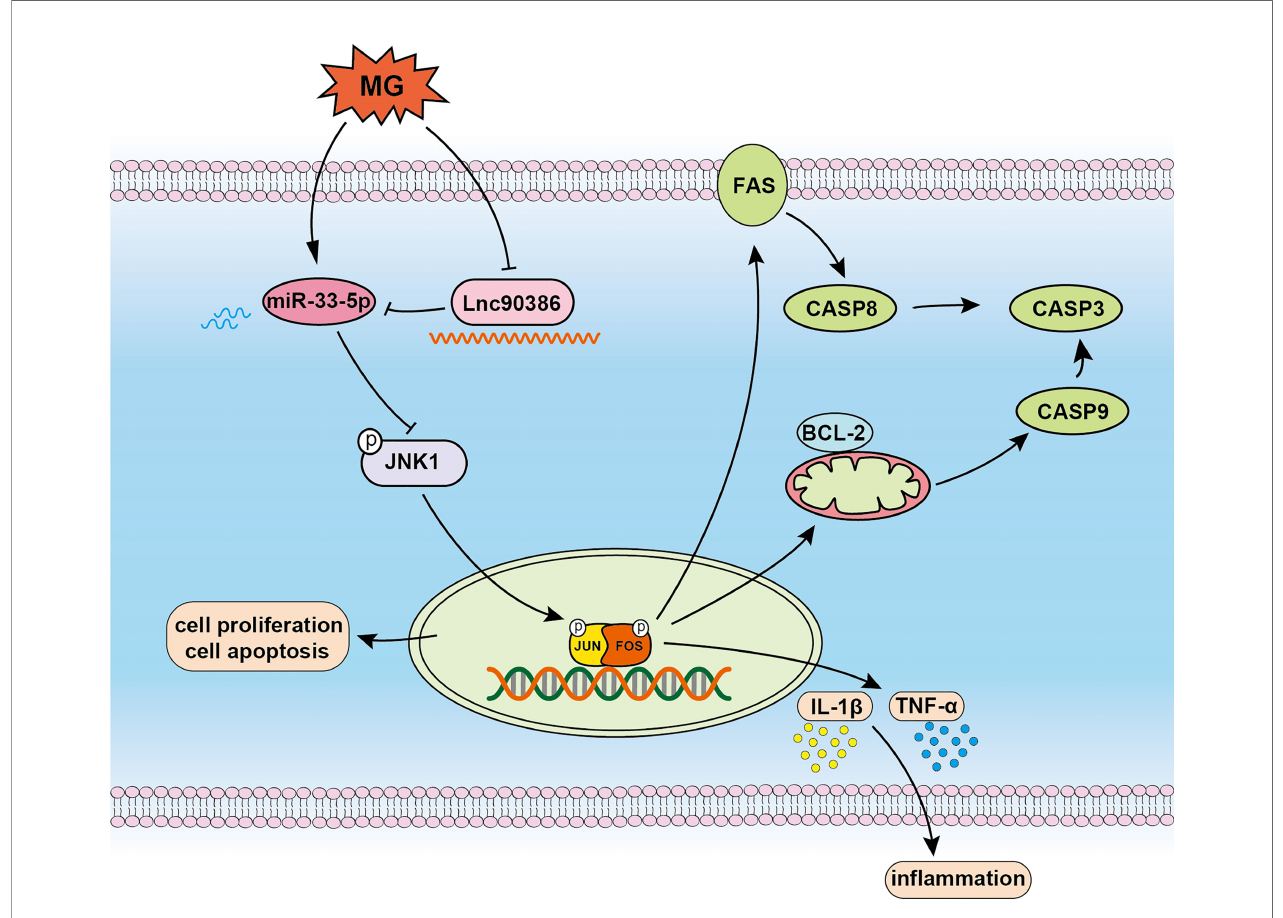
FIGURE 10 | Schematic diagram of the potential roles of Lnc90386/miR-33-5p in DF-1 cells after MG